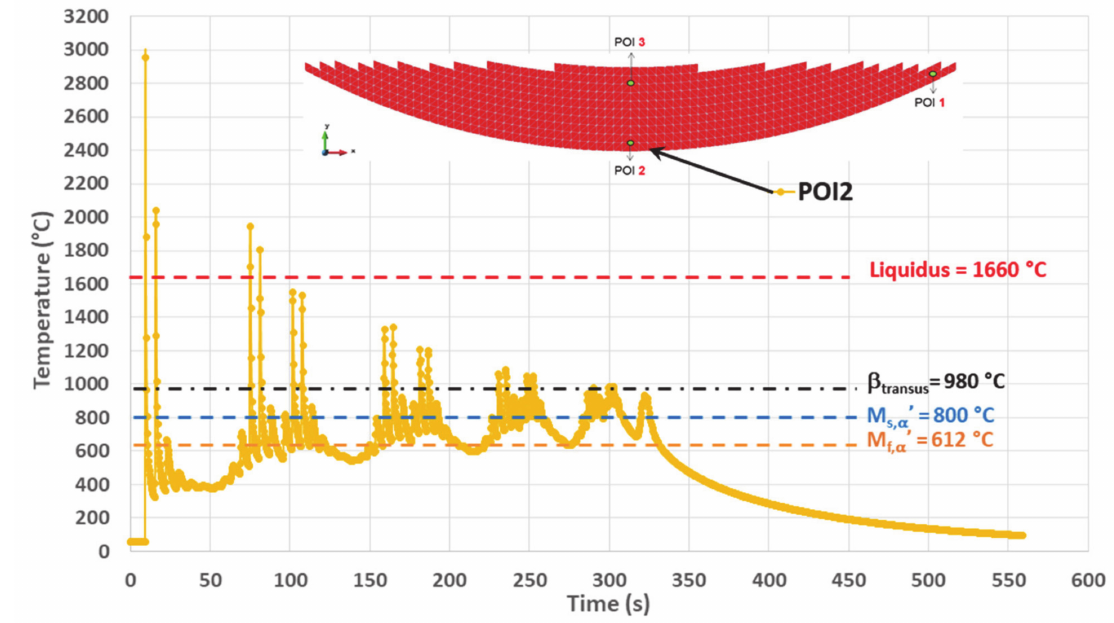
Figure 11. Simulated thermal history of POI2, starting from the material deposition up to the final